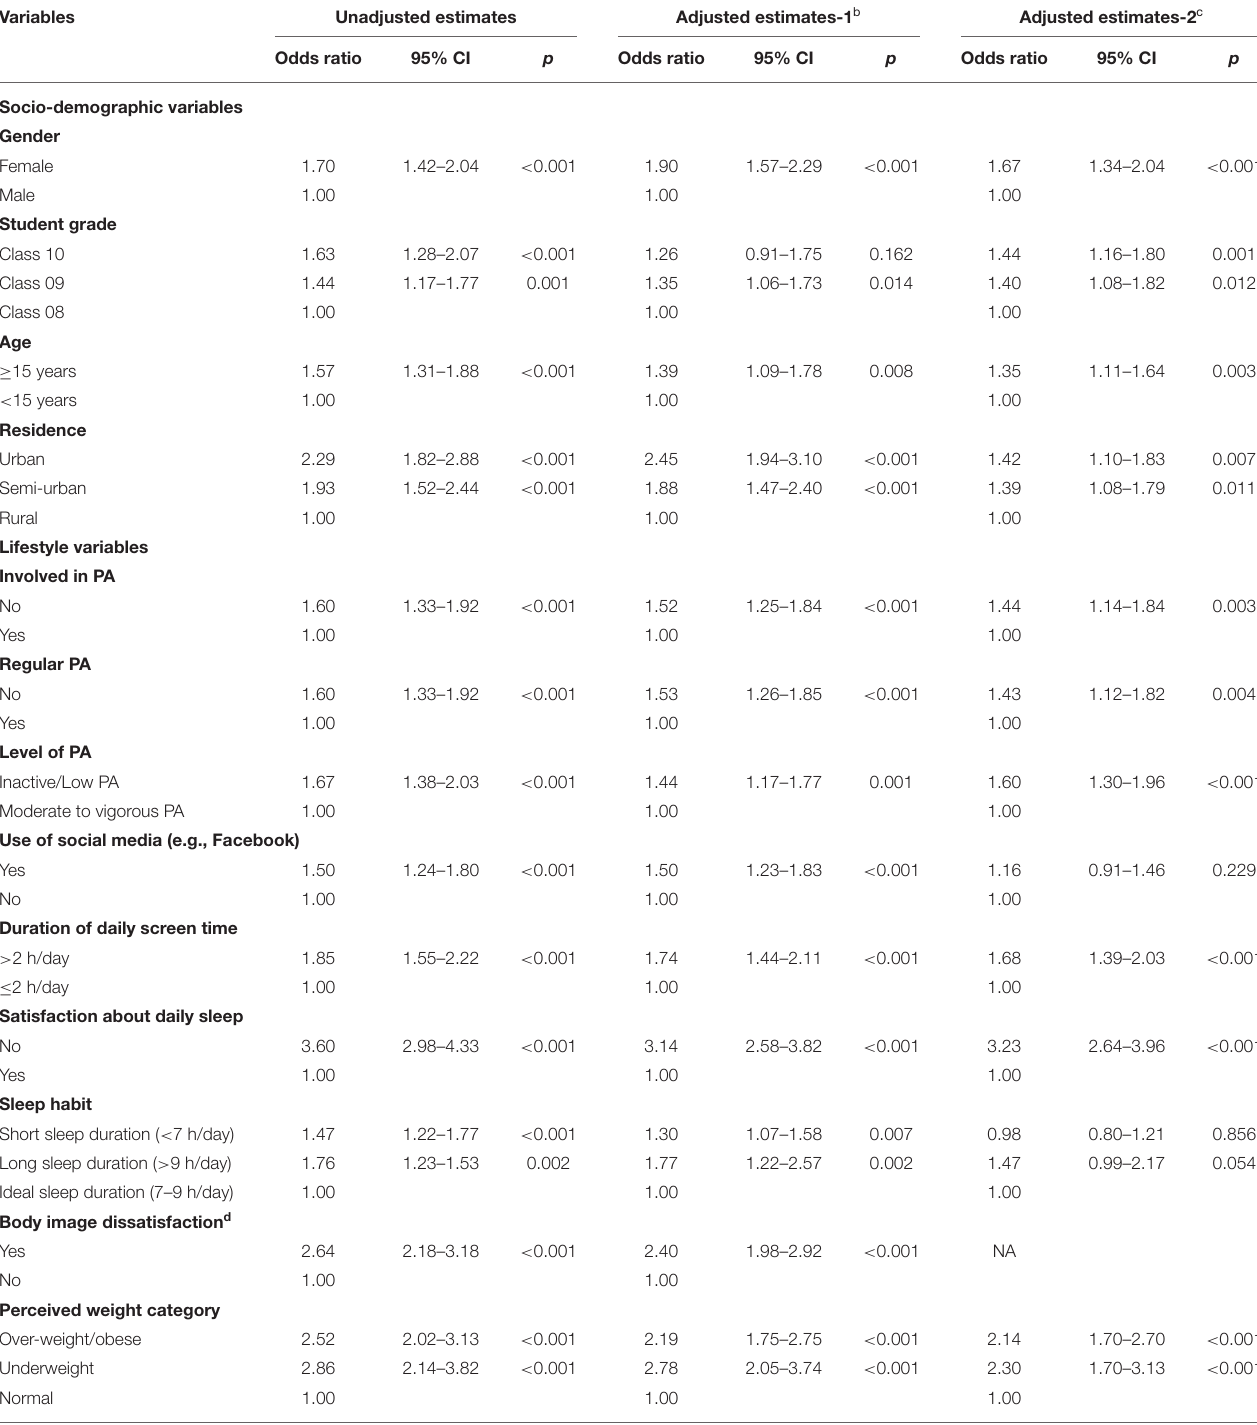
TABLE 3 | Association between predictive study variables and depressive symptom among school adolescents in Dhaka, Bangladesh a